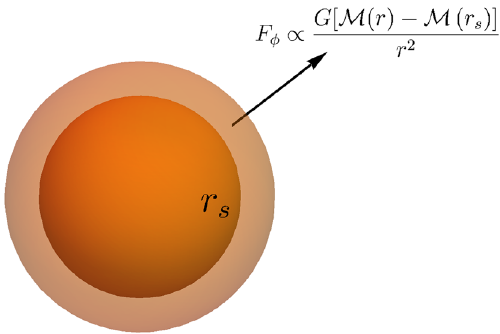
Fig. 3 The thin-shell effect. The fifth-force only receives a contribution from the mass in the thin-shell r s < r <